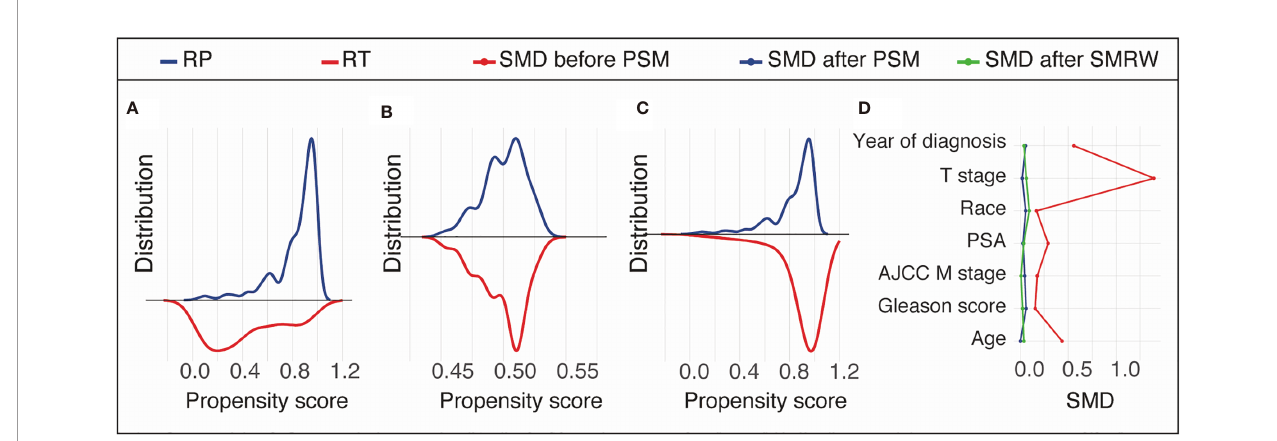
FIGURE 2 | Propensity score distribution in the unmatched cohort (A) , propensity score matching (PSM) cohort (B) , and the standardized mortality ratio weighting (SMRW) cohort (C) and the standardized mean difference (SMD) of the key variables in the unmatched, PSM, and SMRW cohorts (D) . RT , brachytherapy with or without external beam radiation therapy; RP , radical prostatectomy with or without external beam radiation therapy.